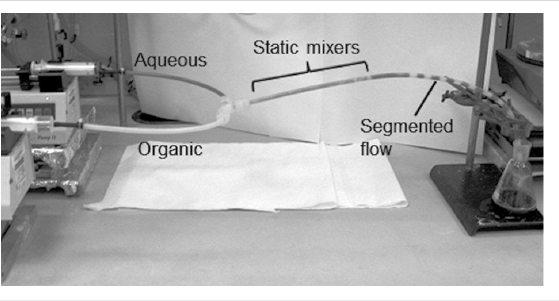
Figure 3: Effect of static mixers on biphasic solution.